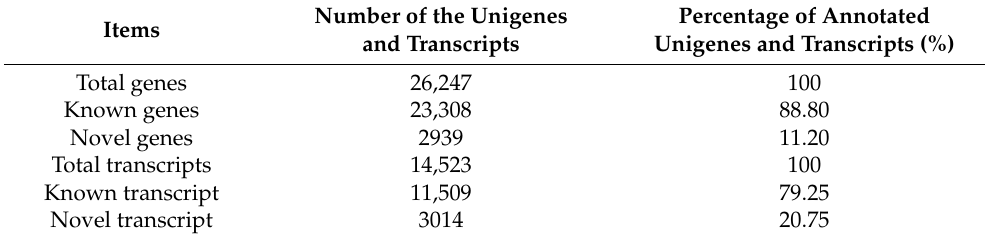
Table 5. Summary of the annotations for the sweet cherry unigenes and